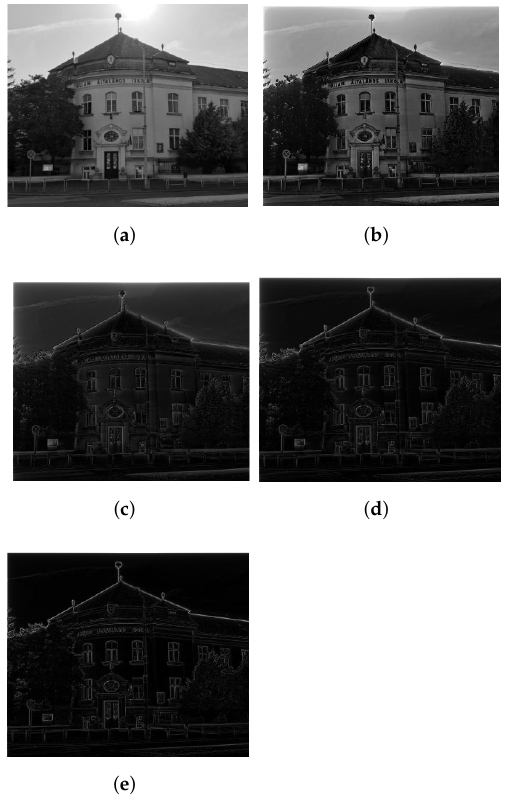
Figure 2. Illustration of Grünwald–Letnikov derivative with different values of α : ( a ) Grayscale test image, ( b ) α = 0.2, ( c ) α = 0.4, ( d ) α = 0.6, ( e ) α =